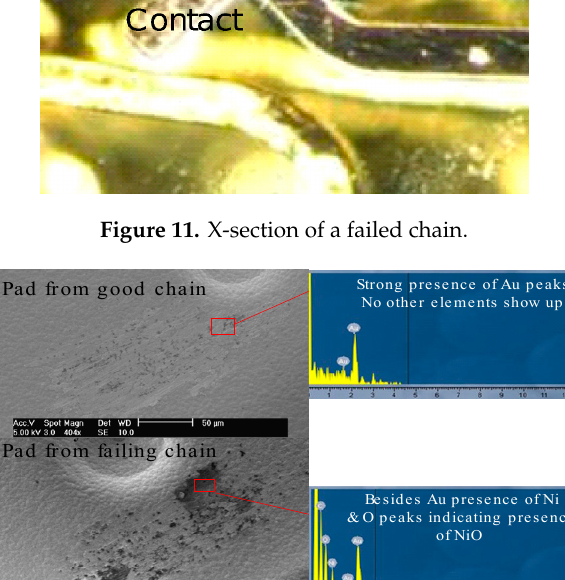
Figure 12. Scanning electron microscope (SEM)of pad from failing chain and good chain.